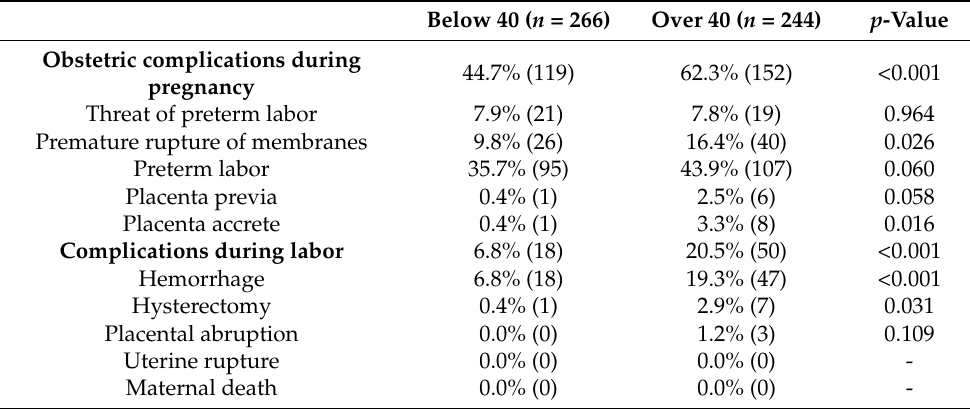
Table 3. Obstetrical complications during pregnancy and